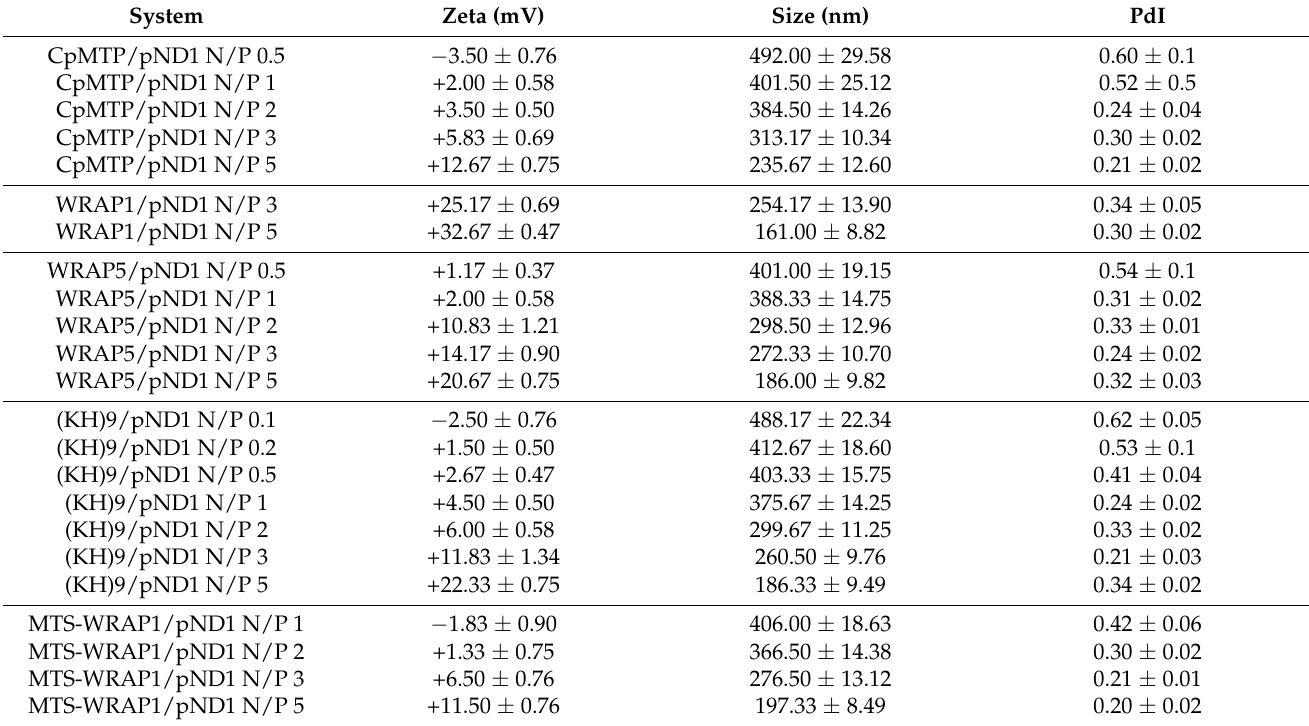
Figure 2. Scanning electron micrographs of CpMTP/pND1 ( A ); WRAP1/pND1 ( B ); WRAP5/pND1 ( C ); (KH)9/pND1 ( D ); MTS-WRAP1/pND1 ( E ); MTS-WRAP5/pND1 ( F ) and MTS-(KH)9/pND1 ( G ) complexes formulated at N/P ratio of 5. Scale bar = 500 nm. Table 2. Average zeta potential, mean size and polydispersity index (PdI) for the various peptide/pND1 complexes formulated at various N/P ratios. The values were calculated with the data obtained from six independent measurements (mean ± SD, n = 6), and analyzed by one-way or two-way ANOVA (GraphPad Software version v.8.01, Inc., San Diego, CA, USA). Statistical significance was accepted at a level of * p <